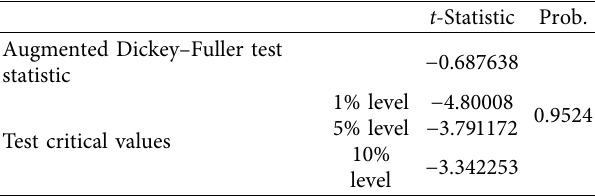
t -Statistic Prob.